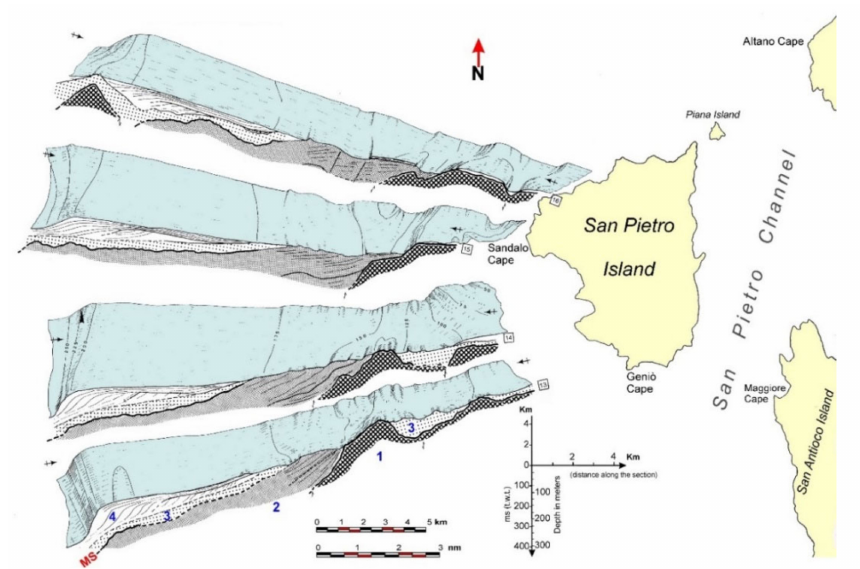
Figure 2. Sectioned block diagram of the Sardinian southwestern continental shelf off the San Pietro Island. ( 1 ) Acoustic basement (volcanic complex—Lower-Middle Miocene); ( 2 ) lower sedimentary sequence (Middle-Upper Miocene); MS) Messinian erosional surface; ( 3 ) sedimentary sequence poorly or not stratified in the lower part, with undulating stratification in the upper part (Lower-Middle Pliocene); ( 4 ) upper sedimentary sequence, prograding complex of the external platform, superficial deposits in the proximal platform (Upper Pliocene—Quaternary) (after Lecca, 2000 modified